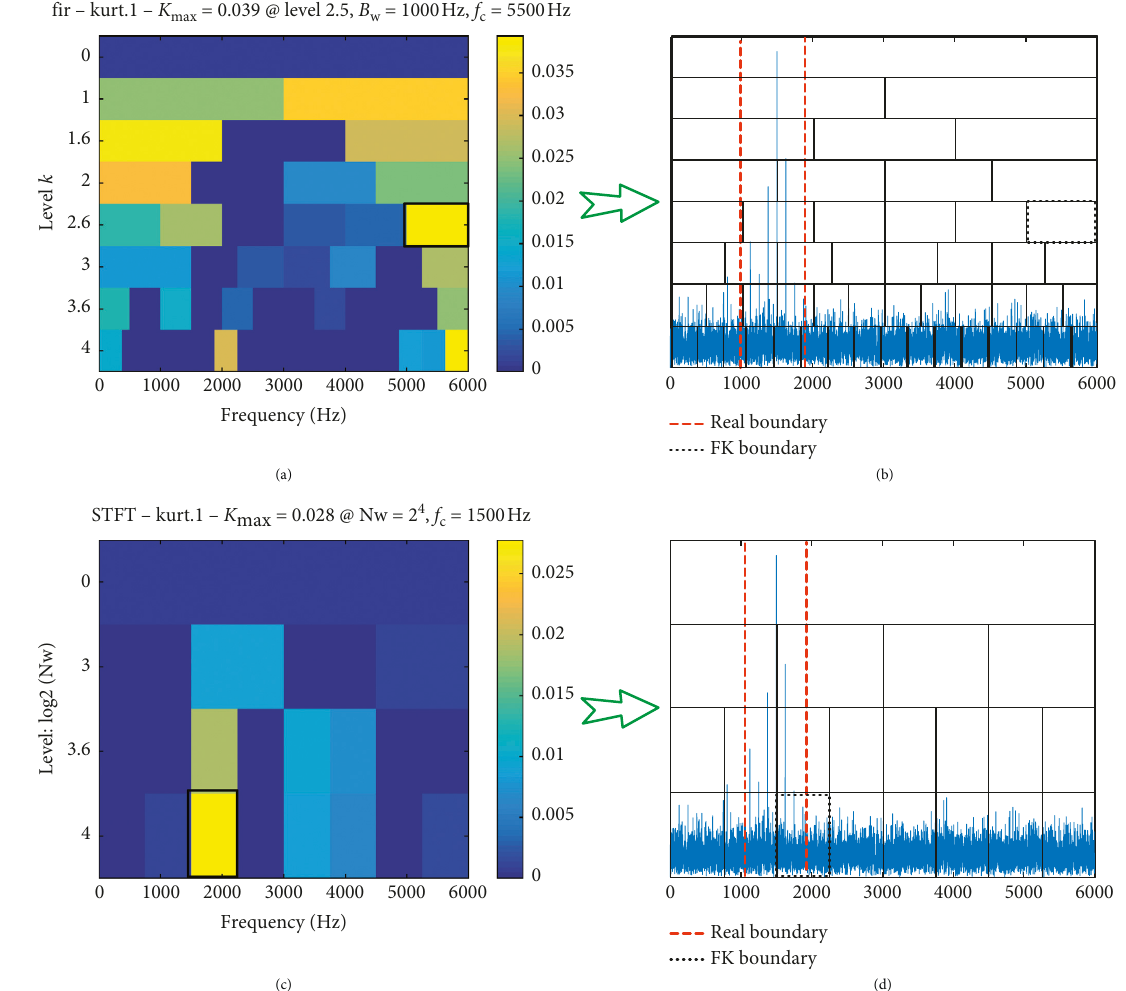
Figure 2: (a) Results by the FIR filter; (b) spectrum and the division method of FIR mode; (c) results by the STFT filter; (d) spectrum and the division method of the STFT